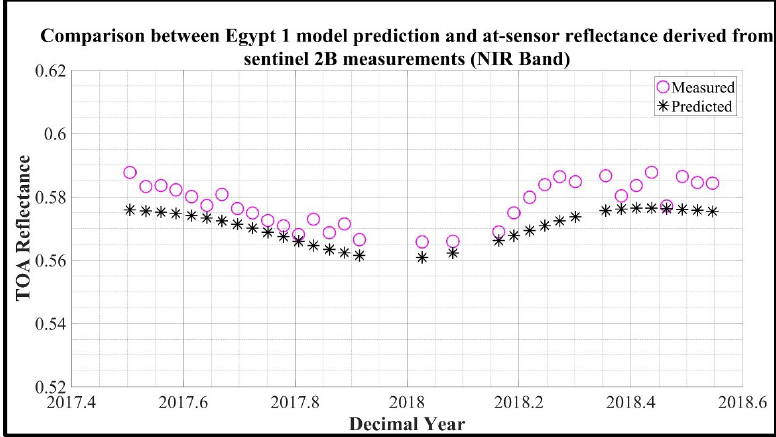
Figure 15. S2B MSI observation of Egypt 1(circle) and model prediction (asterisk).